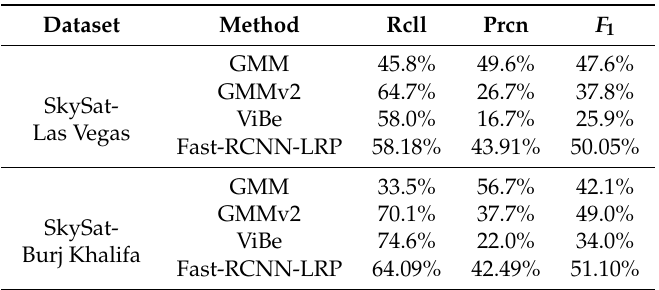
Figure 10. Visualization on detection results by selected approaches on SkySat-Burj Khalifsa dataset. Table 5. Detection results